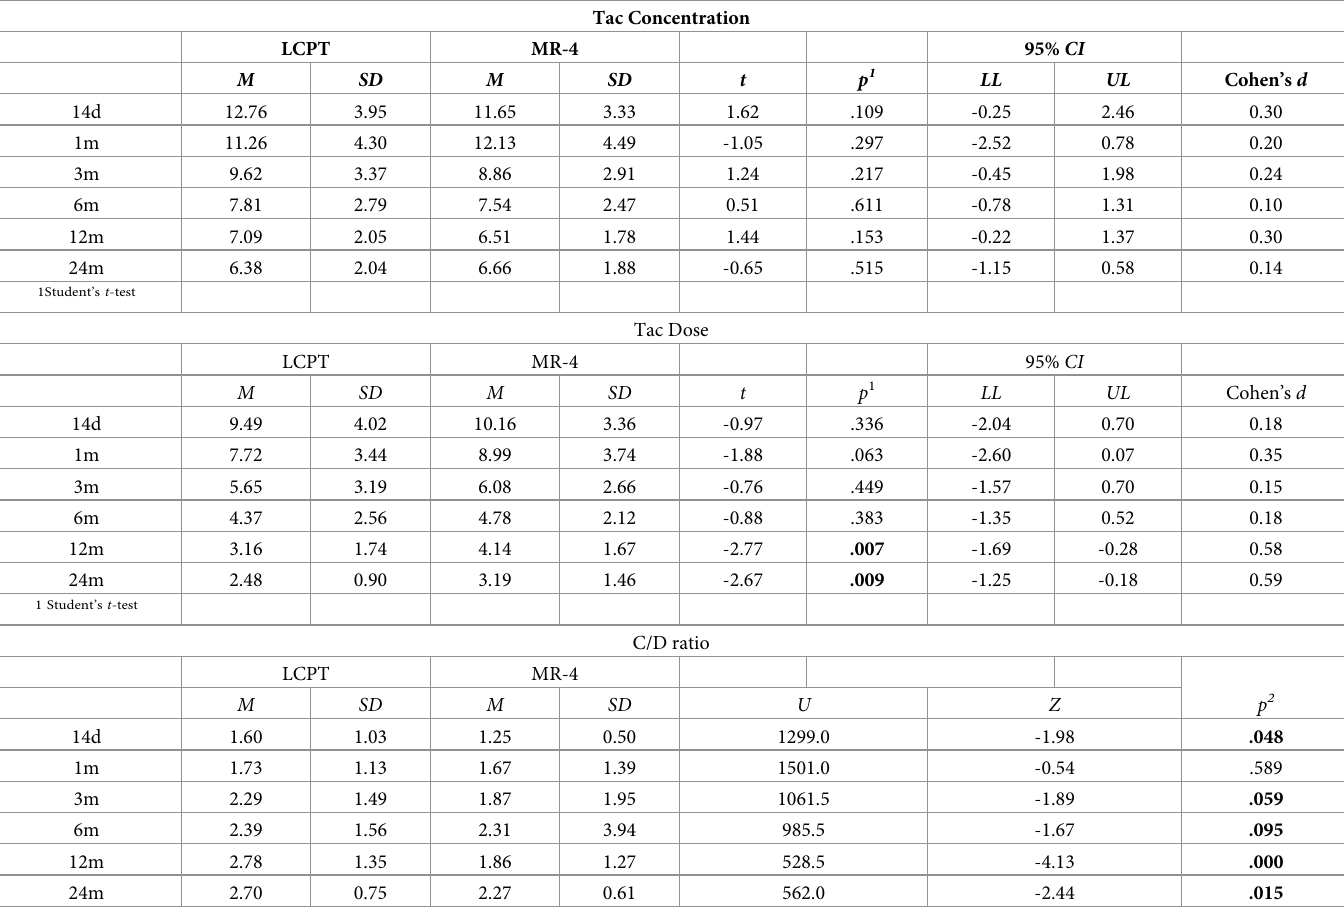
Table 4. Tacrolimus dose, whole blood concentration (C 0 ) and C/D ratio within 24 months follow-up